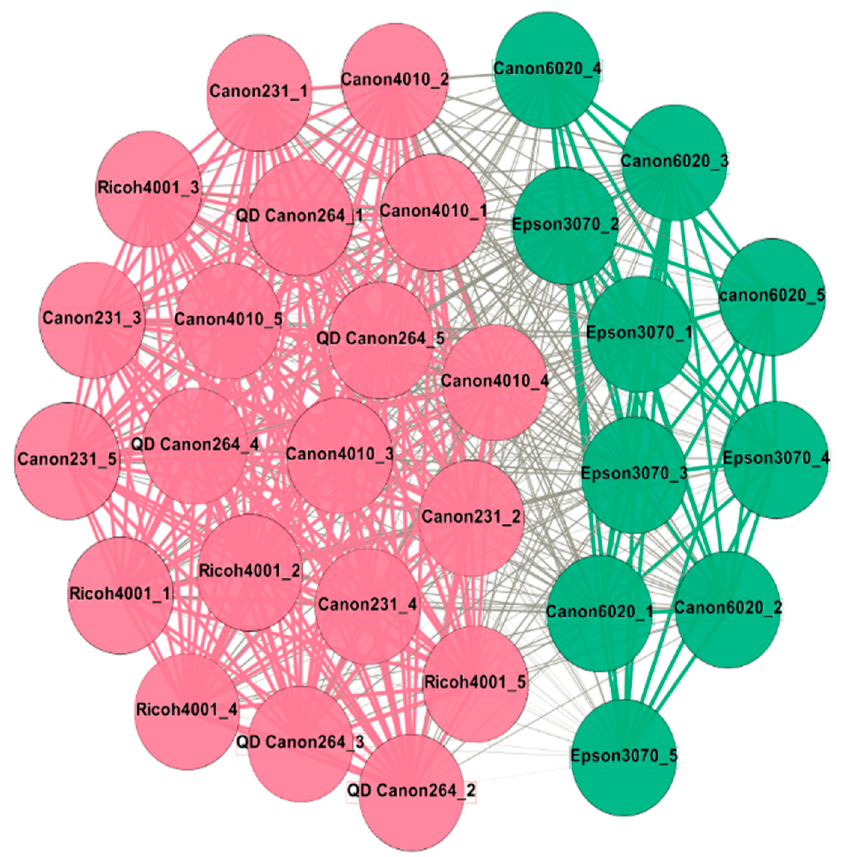
Figure 4. Test 4, visualization of di ff erent ink brands.